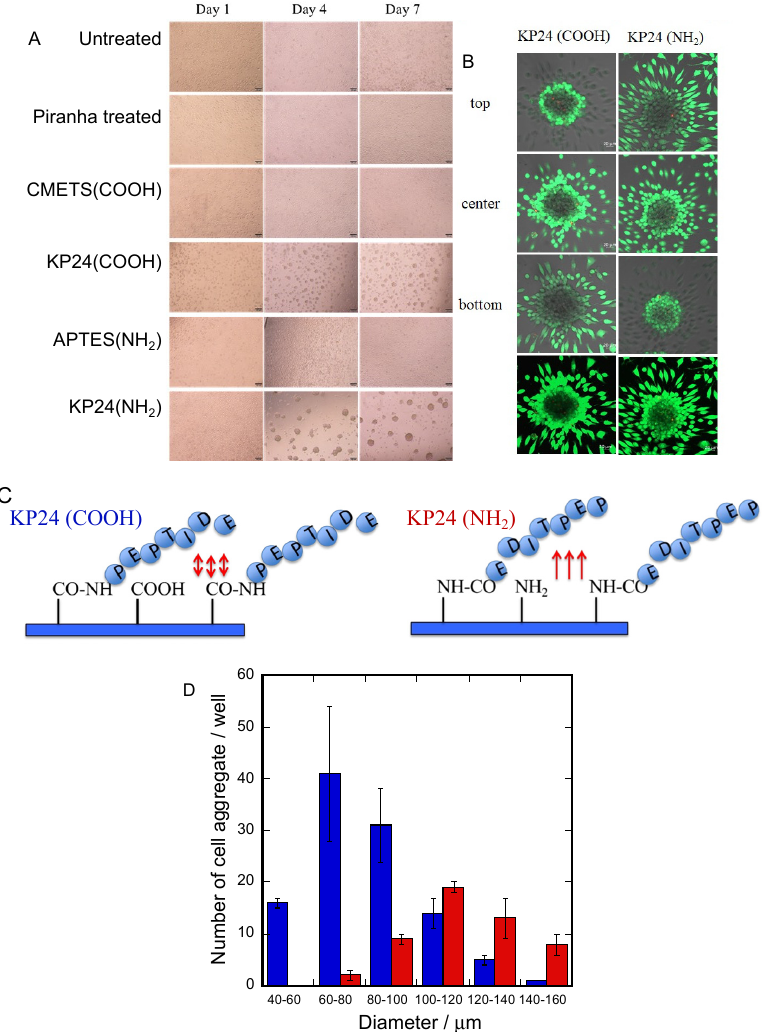
Figure 4. Induction of L929 cell aggregates on KP24-immobilized substrate. ( A ) Microphotographs of L929 cell aggregates in various substrates. Incubation time: 1, 4, 7 days. ( B ) Live/Dead staining of cell aggregates on KP24-immobilized substrates. Green, Live cell; red, Dead cell. ( C ) Image of KP24-immobilized substrates surface. ( D ) Distribution of cell aggregate size. Incubate time, 7 days. Red, KP24 (NH 2 ) substrate; blue, KP24 (COOH)